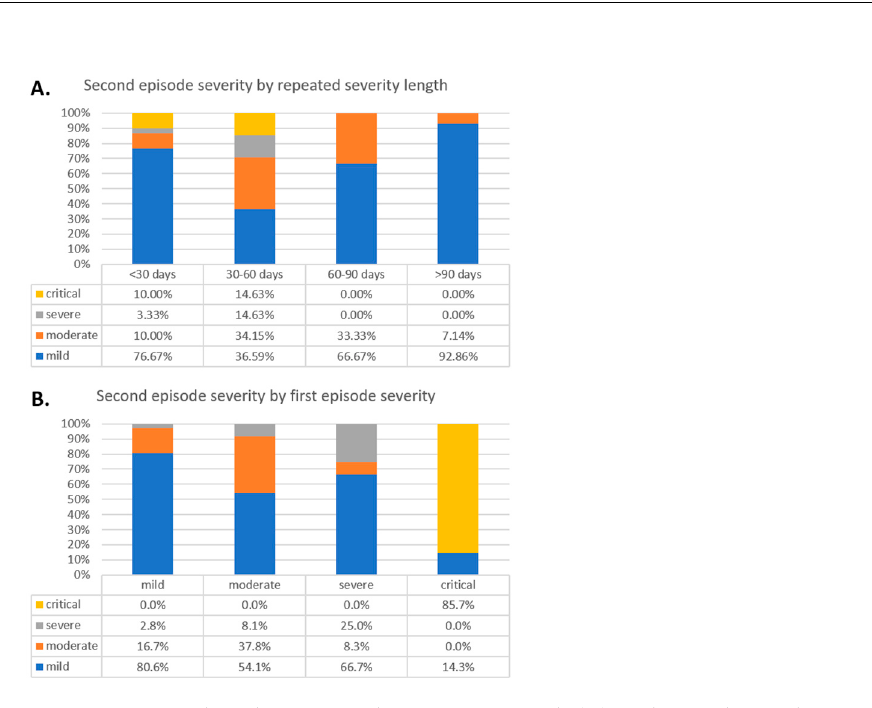
Figure 4. Severity based on repeated positivity intervals ( A ), and second episode’s severity based on the first episode severities ( B ). Table 3. Characteristics of the analyzed patients based on the repeated positivity intervals.